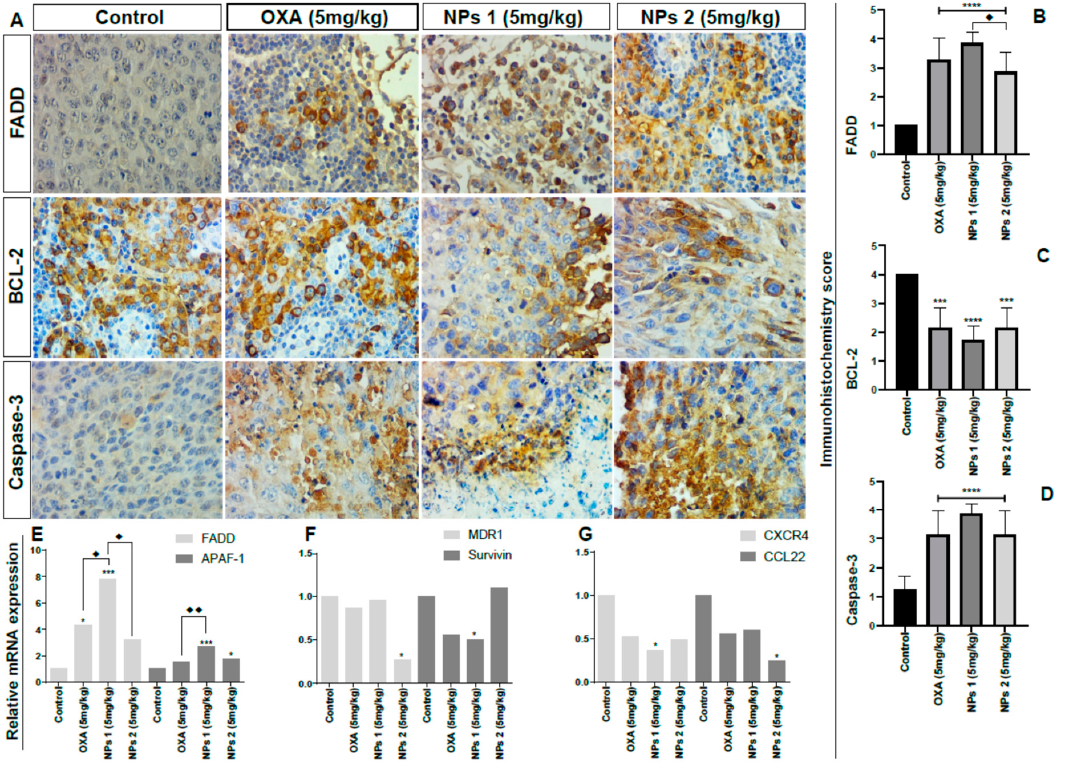
Figure 7. Analysis of apoptosis, drug resistance, and metastasis factors. Representative photomicrographs of immunohistochemistry of tumor fragments of mice receiving different treatments ( A ). Immunohistochemistry score by anti-FADD ( B ), anti-BCL-2 ( C ), anti-caspase-3 ( D ), relative messenger ribonucleic acids (mRNA) expression by RT-PCR for FADD and apoptotic protease activating factor 1 (APAF -1) ( E ), multidrug resistance protein 1 (MDR1) and survivin ( F ), and C-X-C chemokine receptor type 4 (CXCR4), and monocyte-derived chemokine (CCL22) ( G ). All treatment groups were compared to the negative control group (**** p < 0.0001). Comparison between OXA (5 mg / kg)